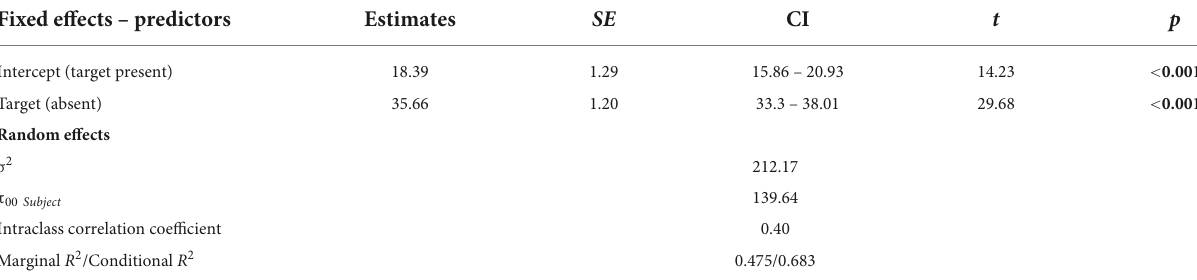
TABLE 6 Estimated coefficients for search slopes in the visual searchtask.